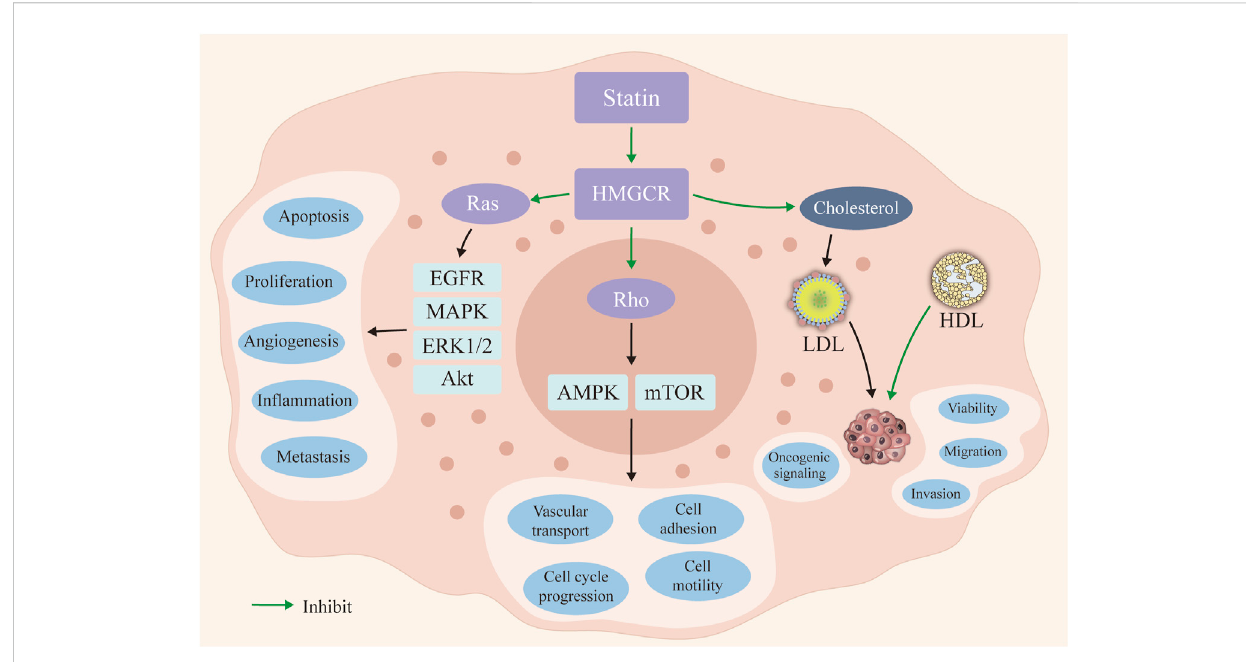
FIGURE 1 The potential mechanisms of statin use in cancer prevention. Statin could inhibit the 3-hydroxy-3-methyl-glutaryl-CoA (HMG-CoA) reductase (HMGCR)andfurtherinhibittheRasandRhosignalingpathways.Then,theoccurrenceandprogressionofthecancercellscouldbeinhibitedinstatinuse. The reduced serum level of LDL inhibits the oncogenic signaling activation. LDL: low density lipoprotein; HDL: high density lipoprotein.